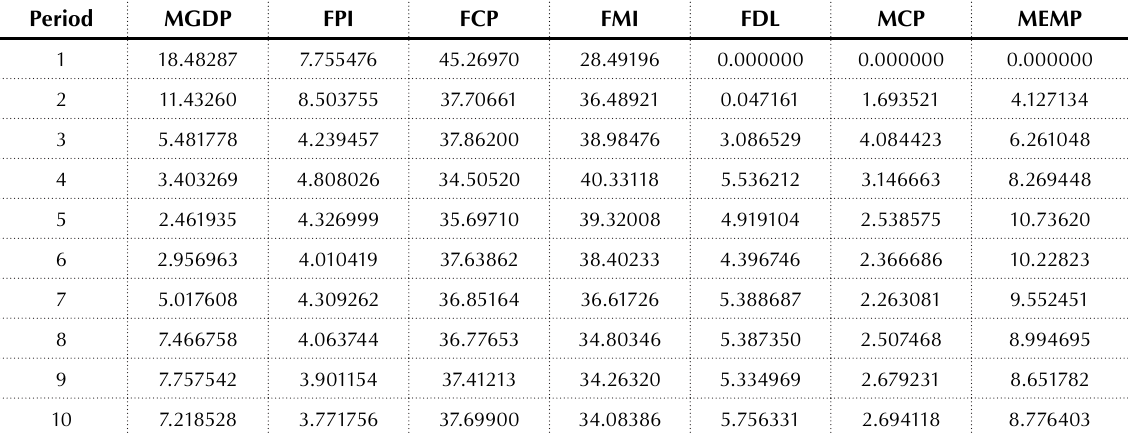
Table 5. Variance decomposition of